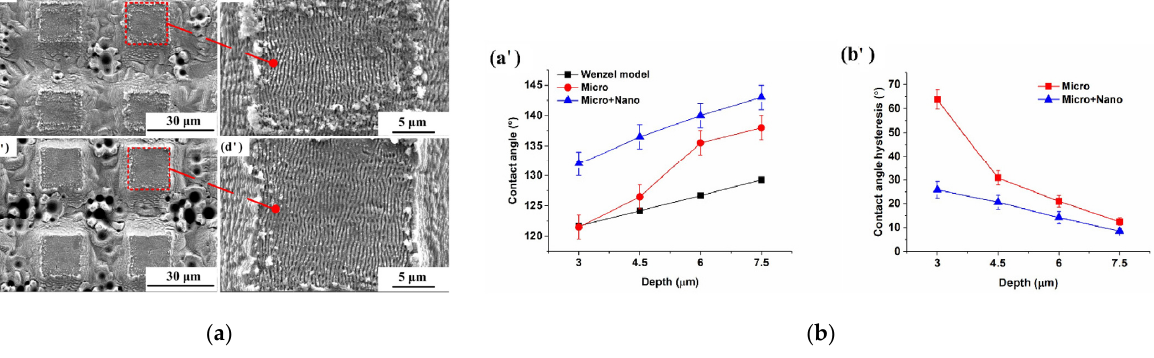
Figure 14. Surface structure and wetting performance of AISI 304 [55]. ( a ) Hierarchical structures at overscan number of ( a’ , b’ ) 9, ( c’ , d’ ) 15; ( b ) effect of depth on the contact angles of CAs ( a’ ) and CAHs ( b’ ). (Open Access).